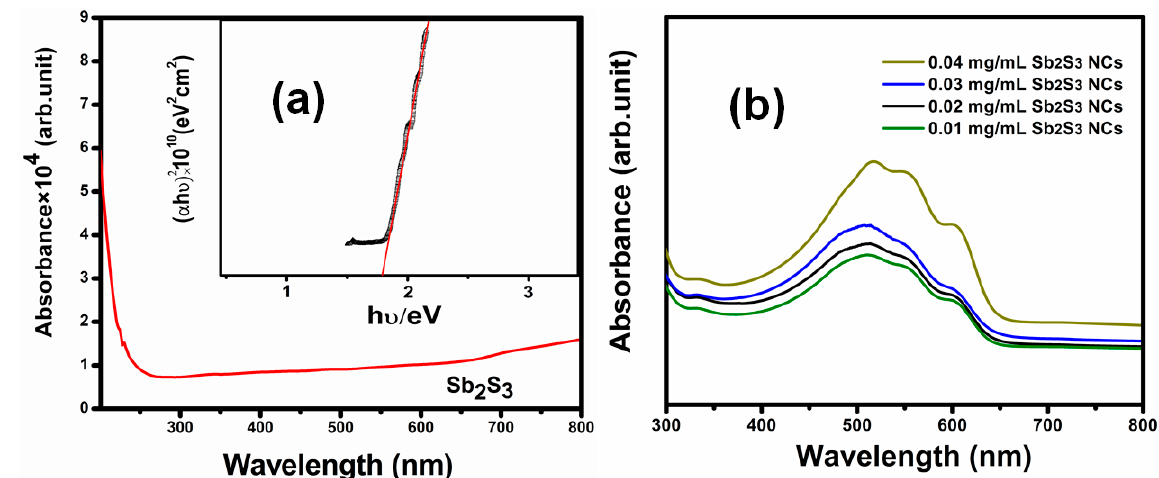
Figure 5. ( a ) UV–visible spectra absorption spectroscopy and band gap energy estimation of the Sb 2 S 3 NCs (insert). ( b ) UV–visible spectra of theP 3 HT:PCBM:Sb 2 S 3 NC polymer fractions blended with different Sb 2 S 3 NC concentrations.